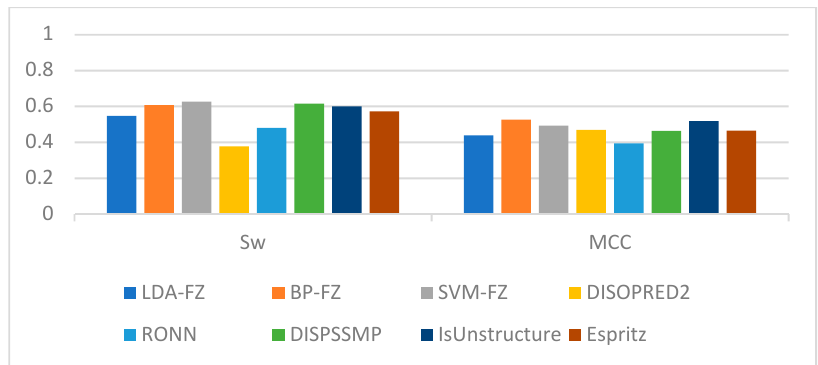
Figure 6. Prediction performance comparison based on test set R80 (Sw, MCC).